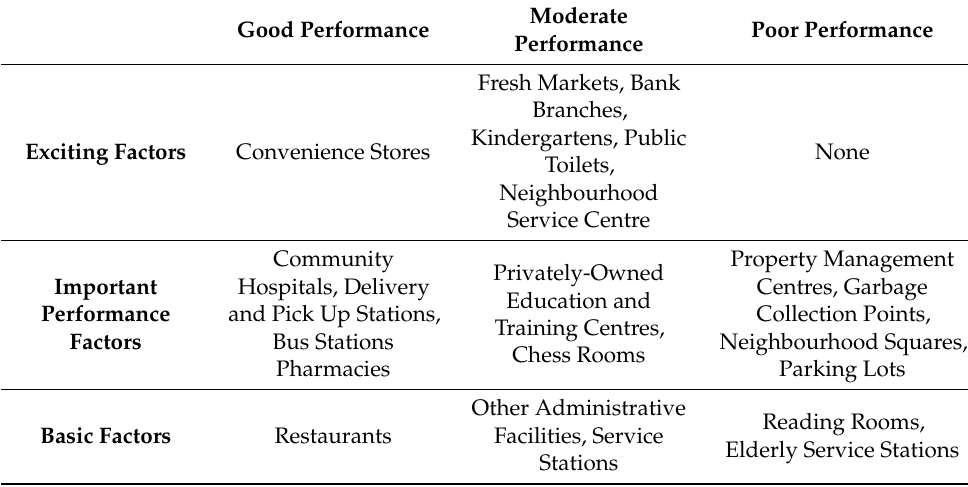
Table 5. The three factors and performance